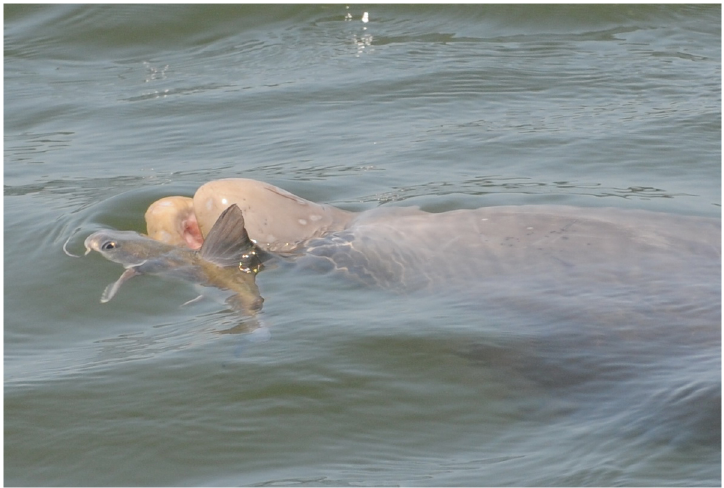
Fig 3. Bottlenose dolphin interacts with a hardhead catfish ( Ariopsis felis ) near Palma Sola Bay, FL (SAR). The dorsaland pectoral spines of the fish appearlocked in their